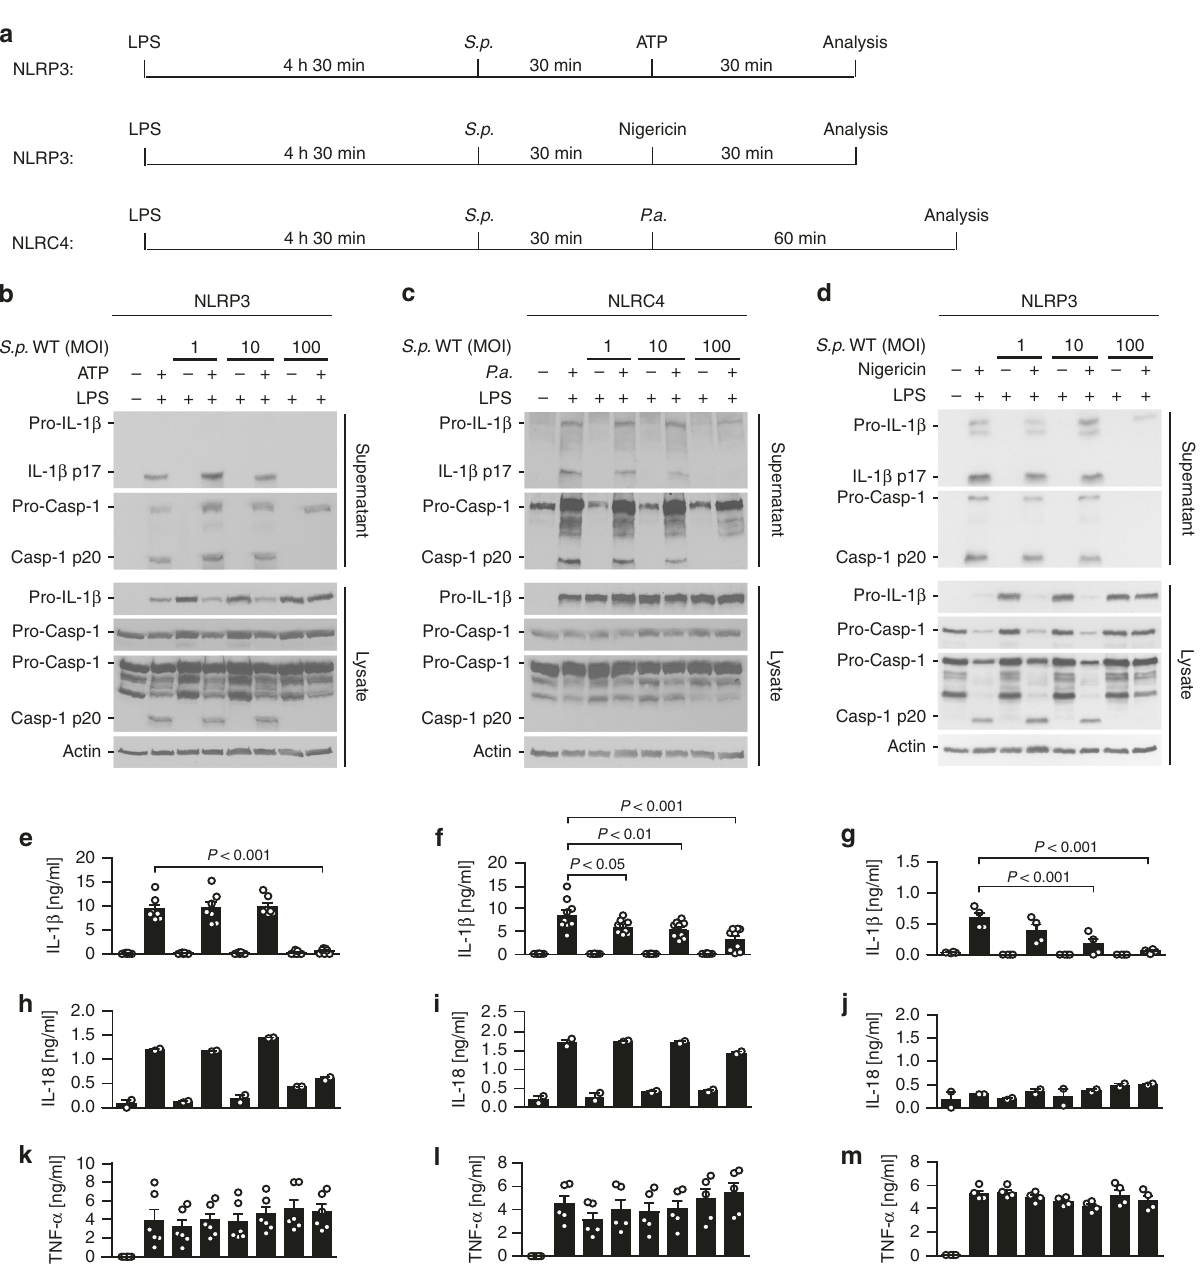
Fig. 2 S. pneumoniae impairs NLRP3- and NLRC4-dependent in fl ammasome activation. a Schematic diagrams of experimental setups used in b to m . Immunoblots of Caspase-1 and IL-1 β processing in LPS-primed BMDMs pre-treated with increasing S.p . WT (D39) doses (MOI 1, 10 or 100) for 30 min before stimulation with b ATP for 30 min, c P. aeruginosa ( P.a ., MOI 20) for 60 min or d nigericin for 30 min. Results are representative of at least 4 independent experiments. ELISA analysis of corresponding supernatants for e – g IL-1 β , h – j IL-18 and k – m TNF- α . Results are obtained from at least two independent experiments; data are shown as mean ± s.e.m. P values determined by one-way ANOVA followed by Bonferroni post-test. Source data are provided as a Source Data fi